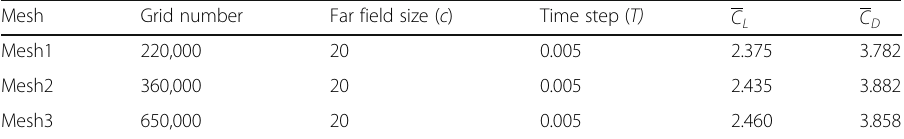
Table 1 Grid-independence test